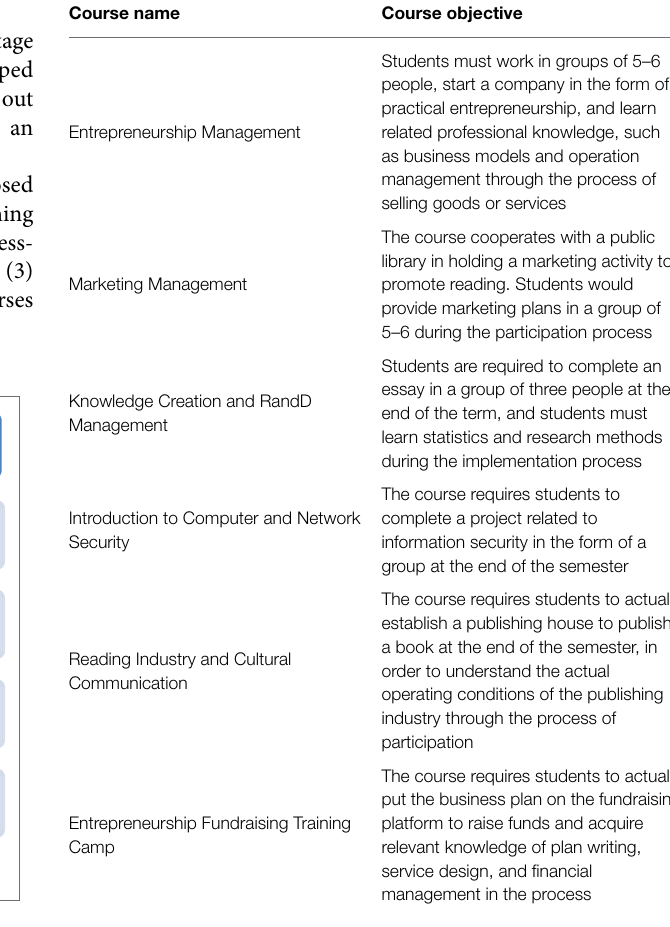
TABLE 1 | The description of courses selected in the